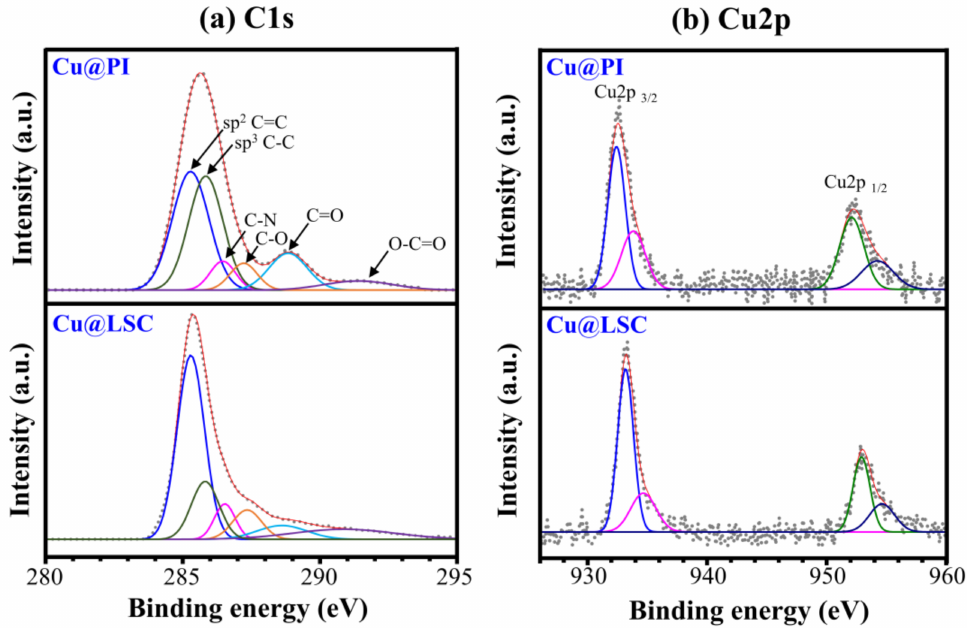
Figure 8. ( a ) C1s and ( b ) Cu2p spectra of Cu@PI and Cu@LSC via XPS